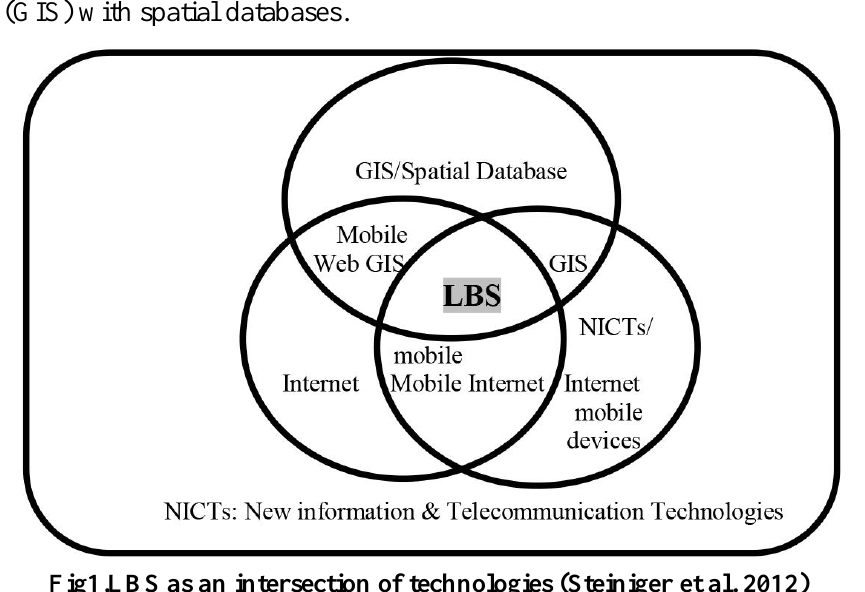
Fig1.LBS as an intersection of technologies (Steiniger et al.